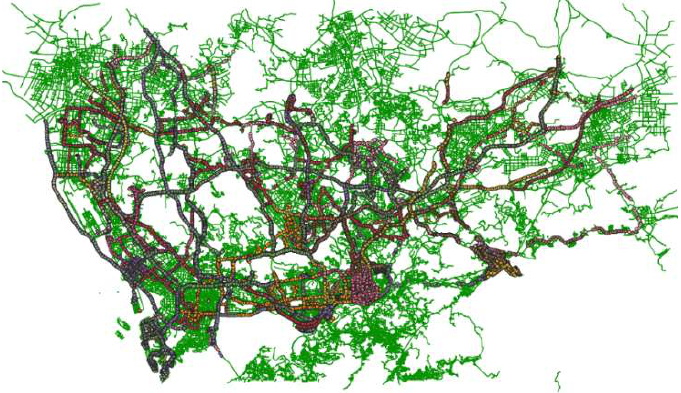
Figure 8. Distribution of the GPS trajectories. The green background is the road network, and other colored lines are trajectories.